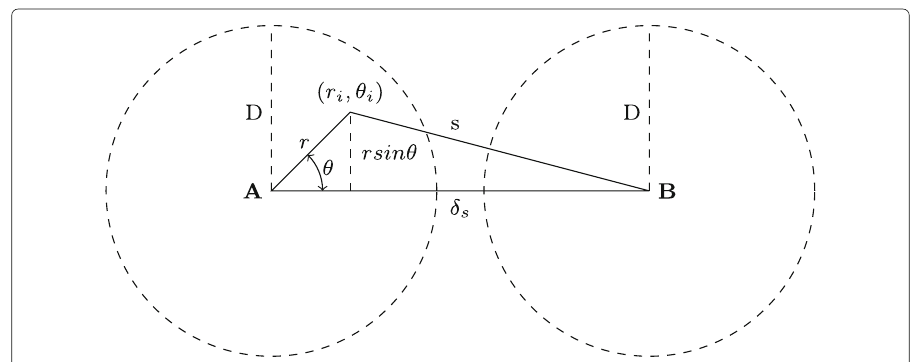
Fig. 4 Geometry of the dynamic model in a 2-D metric space. The two distinct populations of nodes are distributed homogeneously about the two loci A and B in a circle of radius D . These are separated by a distance δ s , and for a given node in set A its distance s is a function of its coordinate ( r i , θ i ) relative to the locus of